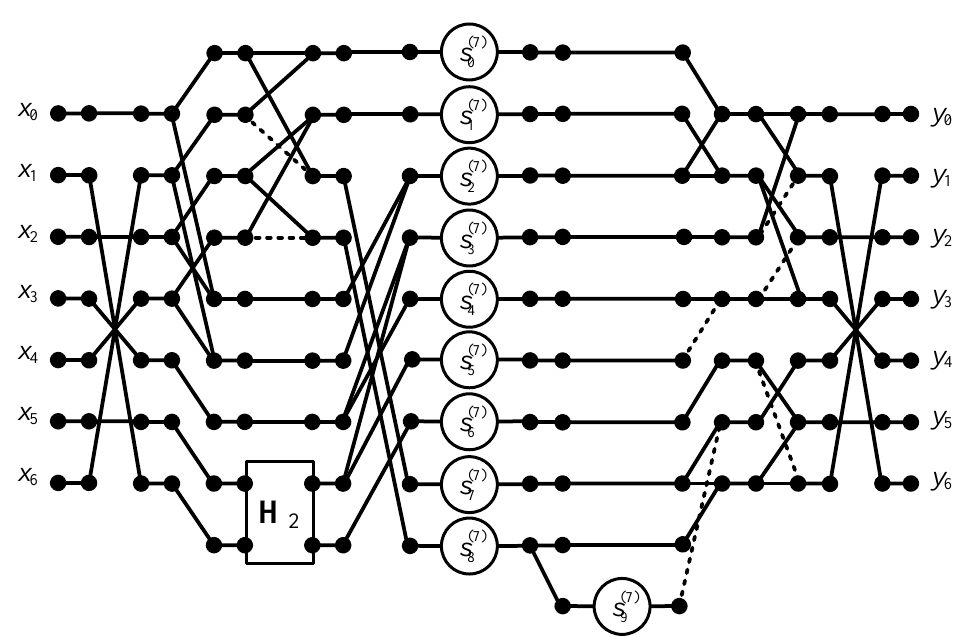
Figure 6. Signal flow graph of the algorithm for computing the 7-point